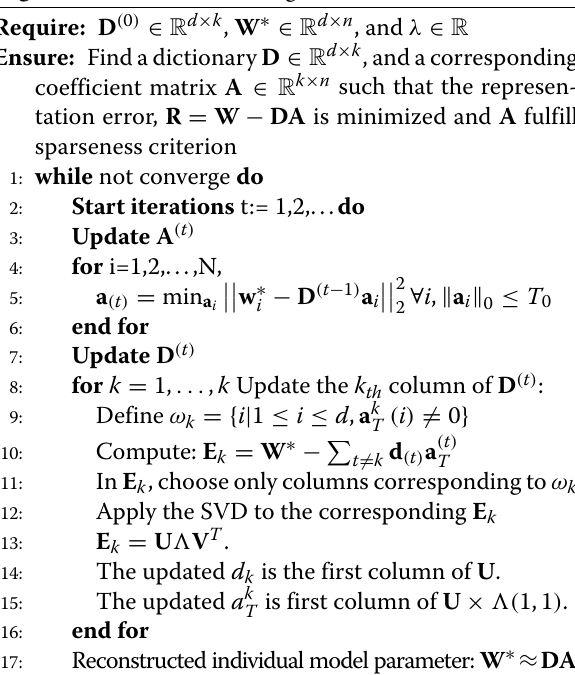
Algorithm 1 The DL-CHI